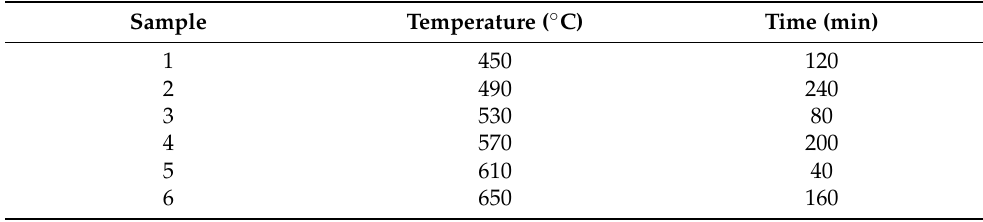
Table 8. The uniform design experimentation (UDE) method for annealing parameters.